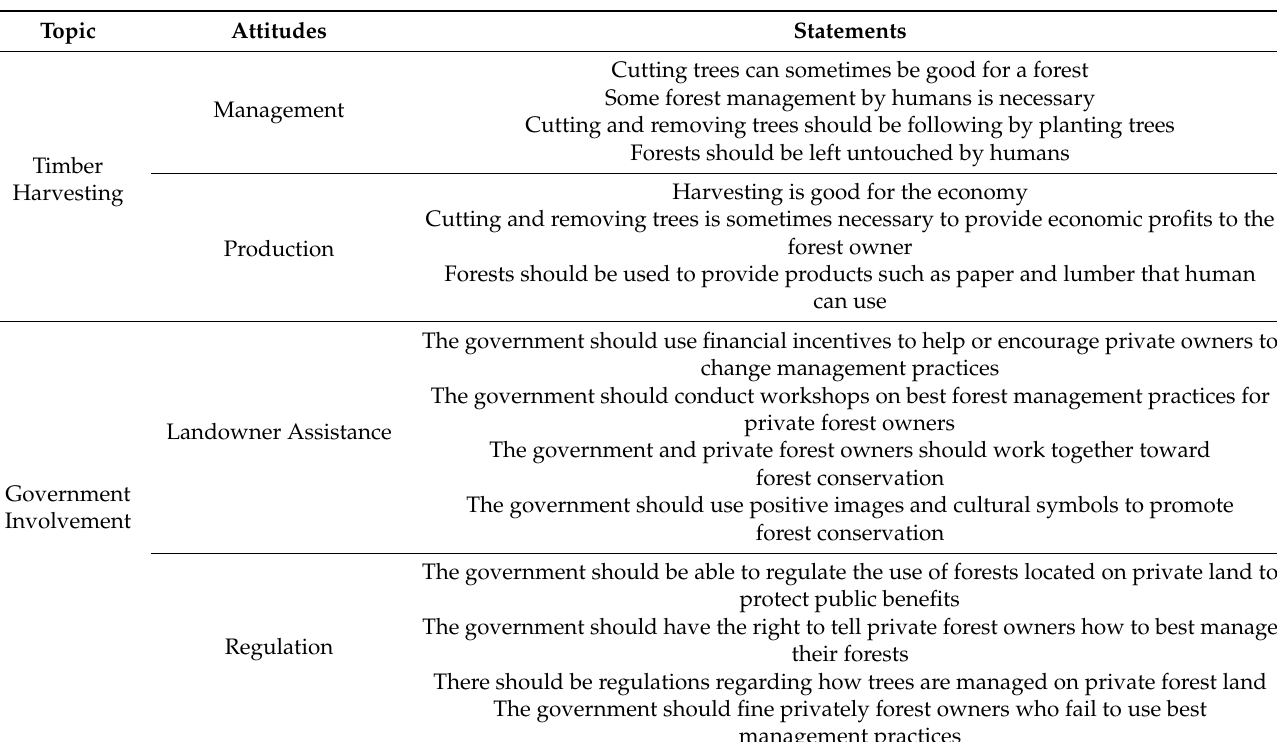
Table 2. Statements used to measure public attitudes towards timber harvesting and government involvement on a 5-point Likert